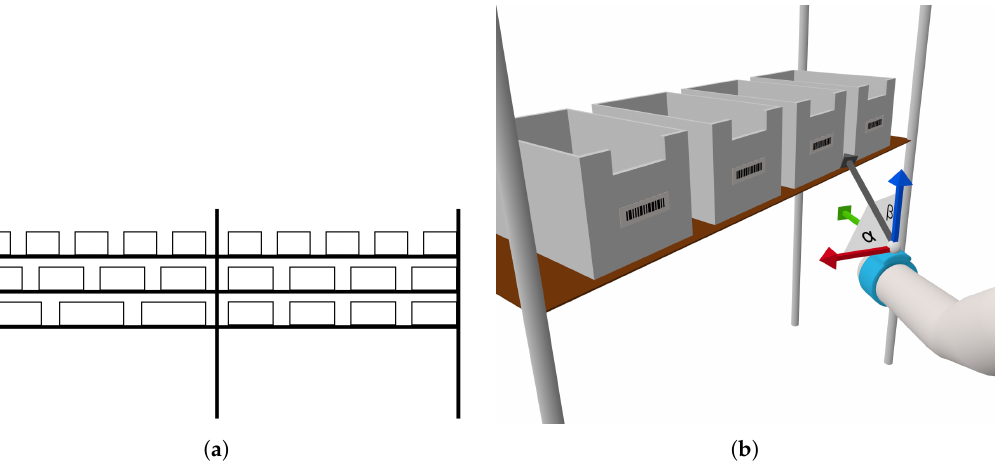
Figure 1. ( a ) Schematic of the shelves in our test environment; ( b ) Angle features from the wristband used for